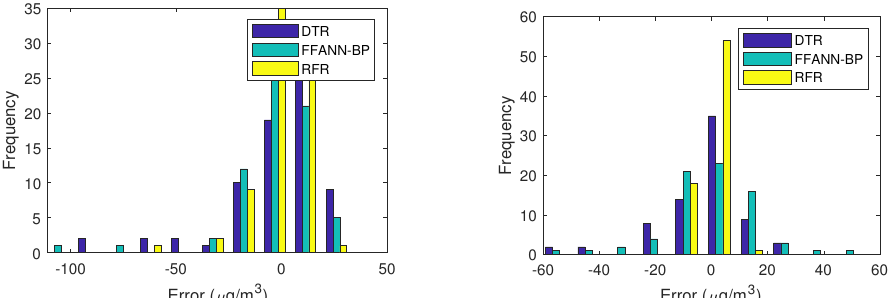
Figure 11. The error histogram of the prediction for O 3 and SO 2 at Ma Lian